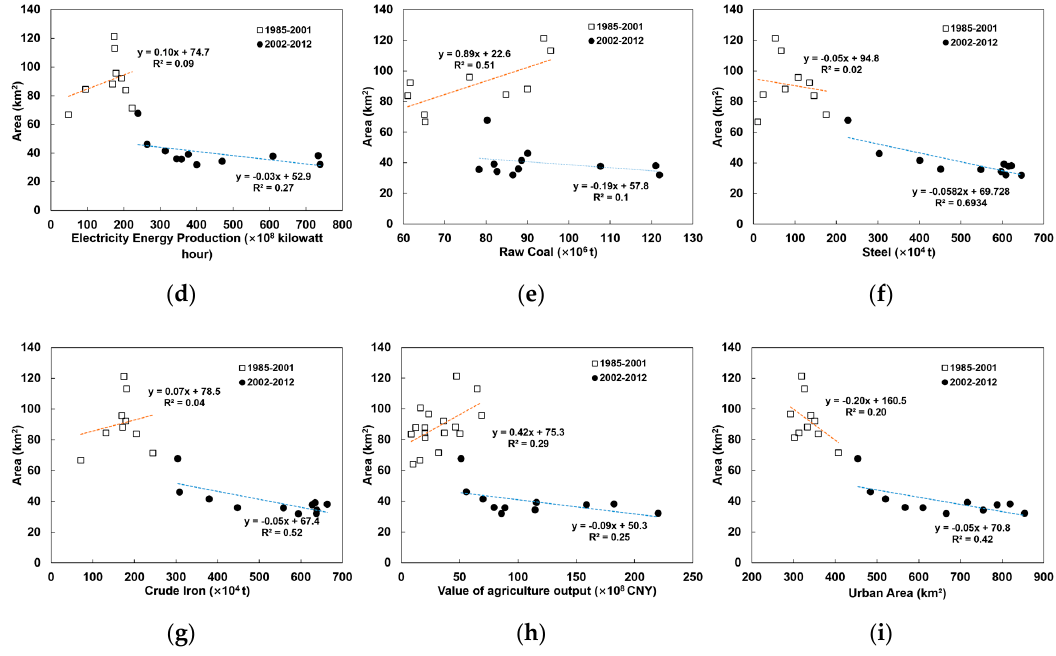
Figure A4. Scatterplots of Guanting reservoir water extents against ( a ) precipitation, ( b ) GDP, ( c ) population, ( d ) electricity energy production, ( e ) raw coal production, ( f ) steel production, ( g ) crude iron production, ( h ) value of agriculture output and ( i ) urban area during 1985–2001 and 2002–2012.